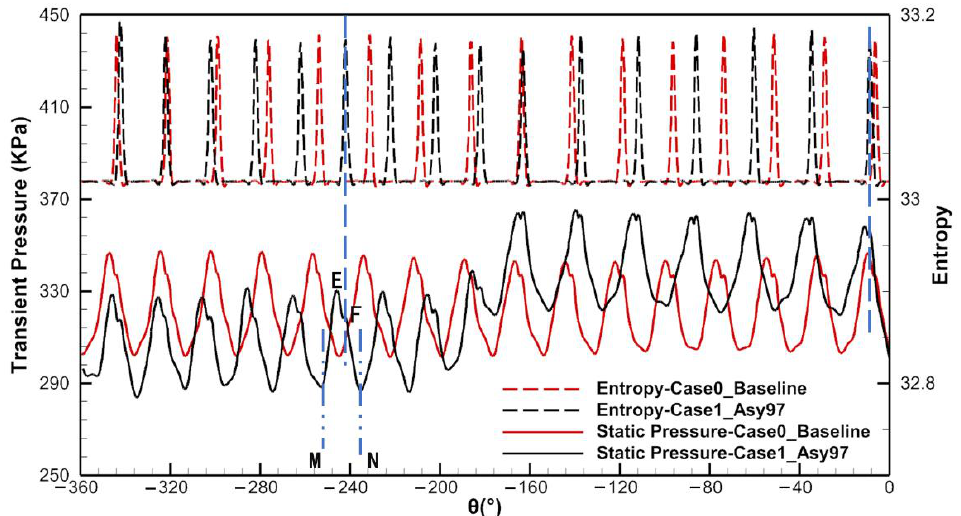
Figure 15. Circumferential distribution of the transient pressure and entropy (midspan).